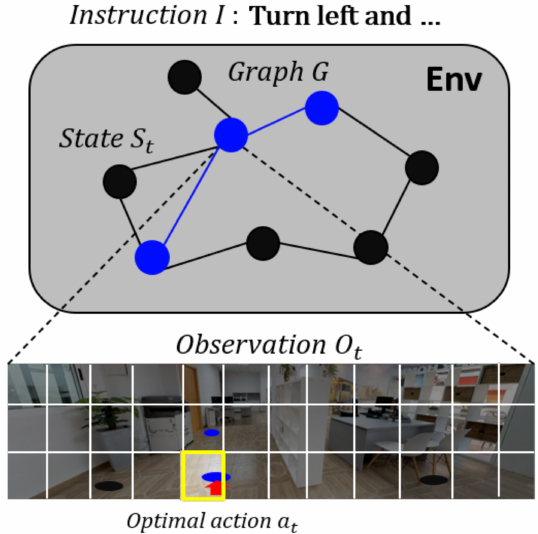
Figure 2. Illustration of the VLN